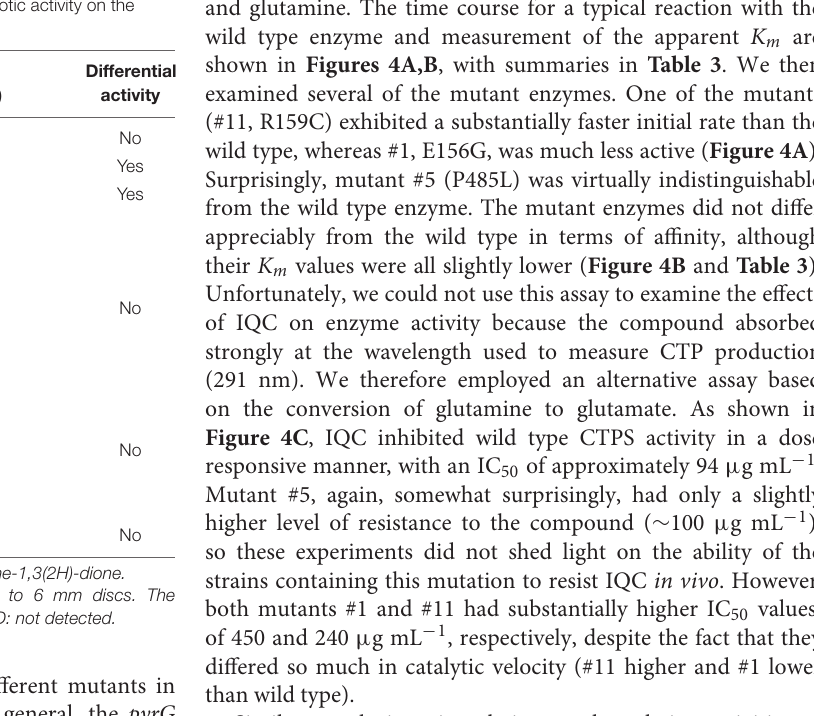
Differential zone (mm)